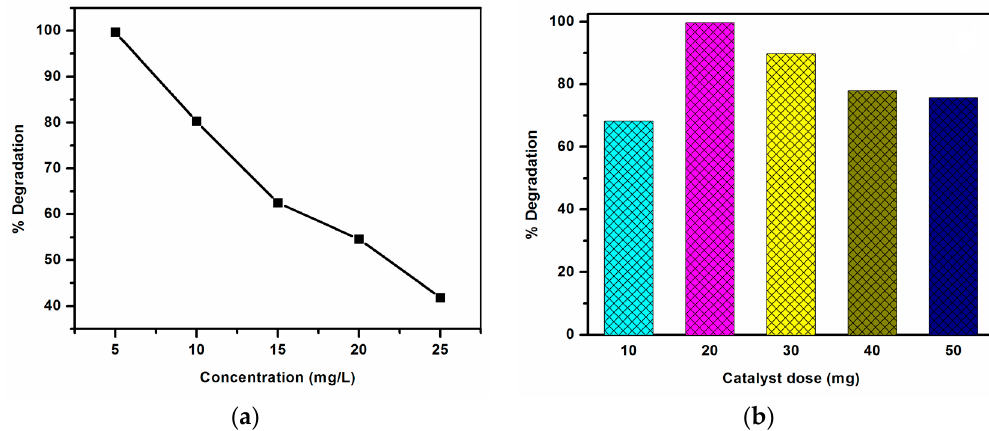
Figure5. E ff ectof( a )initialdyeconcentrationand( b )catalystdosageonthephotodegradatione ffi Figure 5. Effect of ( a ) initial dye concentration and ( b ) catalyst dosage on the photodegradation efficiency.